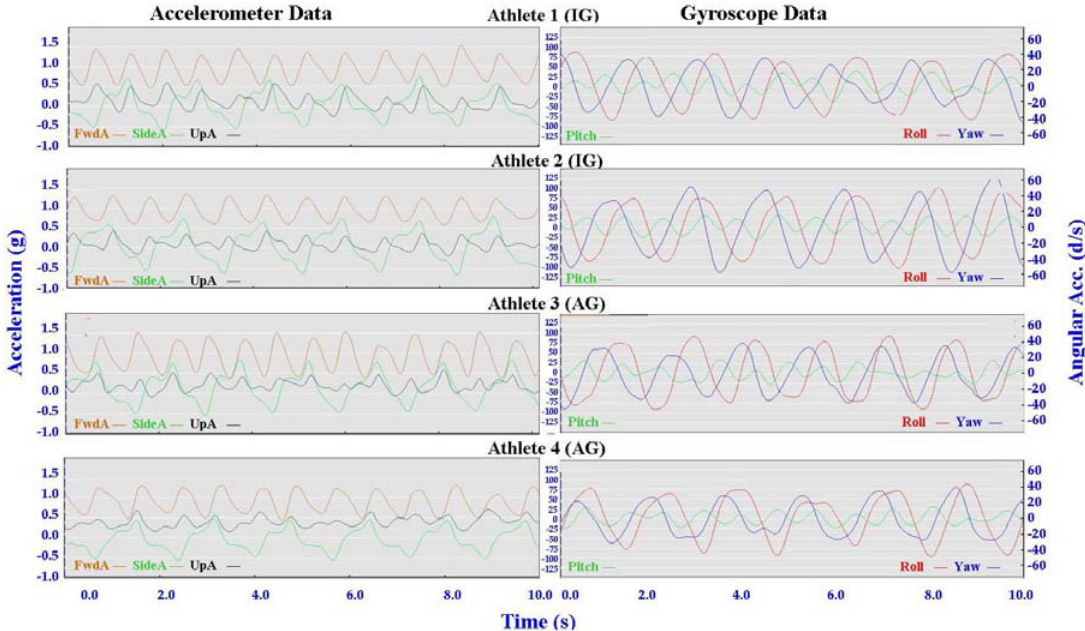
Figure 16. Comparison of Free Skate (G5) gyroscope and accelerometer traces for four athletes (two from the IG and two from the